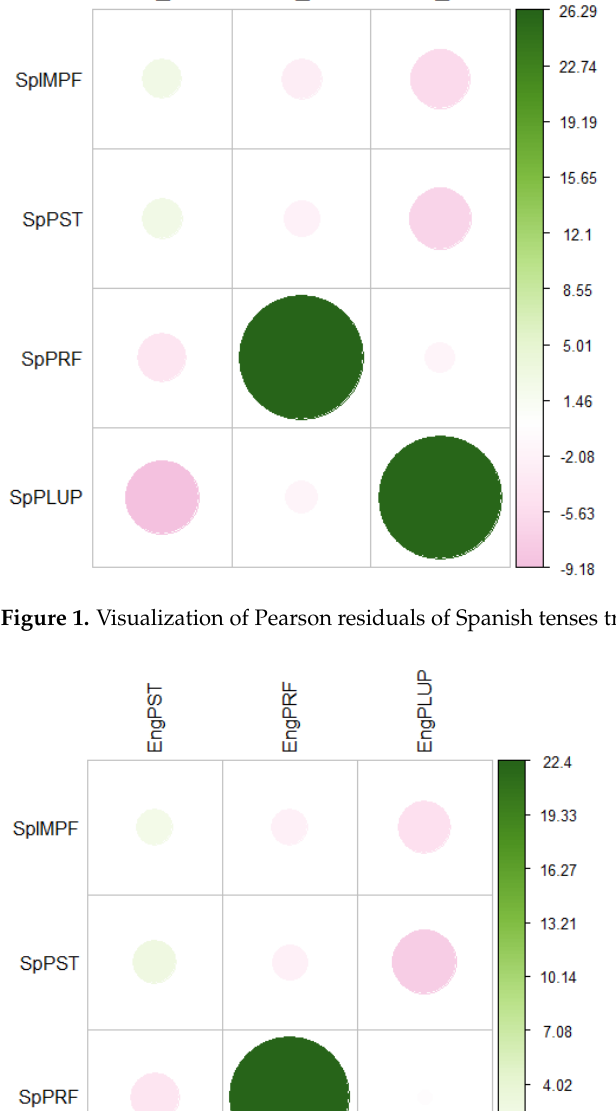
Figure 3. Visualization of Pearson residuals of Spanish tenses translated to French tenses in narration. Let us now turn to the 527 predicates that occurred in dialogue. The data are presented in Table 2. Table 2. Number of Spanish forms (rows) translated to Dutch, English, and French forms (columns) in dialogue, with the relative proportion in % between brackets. Dialogue